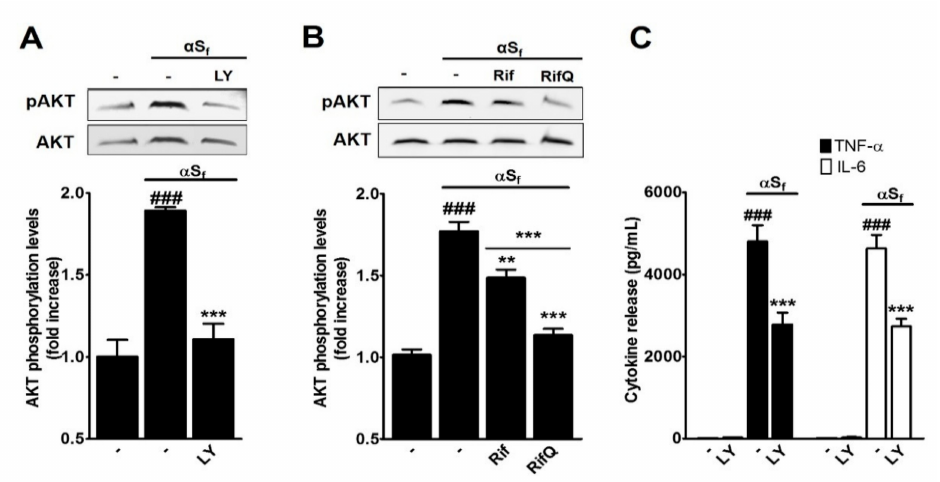
Figure 5. Rif and RifQ inhibit a PI3K-dependent mechanism. ( A ) Western blot analysis of protein kinase B (AKT) phosphorylation in control and α S f -treated cultures exposed or not to the PI3K-specific inhibitor LY (2.5 µ M). ( B ) Western blot analysis of AKT phosphorylation in control and α S f -activated microglial cells treated or not with 100 µ M of Rif or RifQ. A representative blot is included (top), and relative levels of pAKT / AKT are shown (bottom). ( C ) TNF- α (filled bars) and IL-6 (open bars) released by microglial cells pretreated or not with LY prior to stimulation with α S f . Values are shown as means ± SEM of four independent experiments performed in triplicate. Note: ### p < 0.001 vs. controls. ** p < 0.01 vs. α S f and *** p < 0.001 vs. α S f or Rif vs.